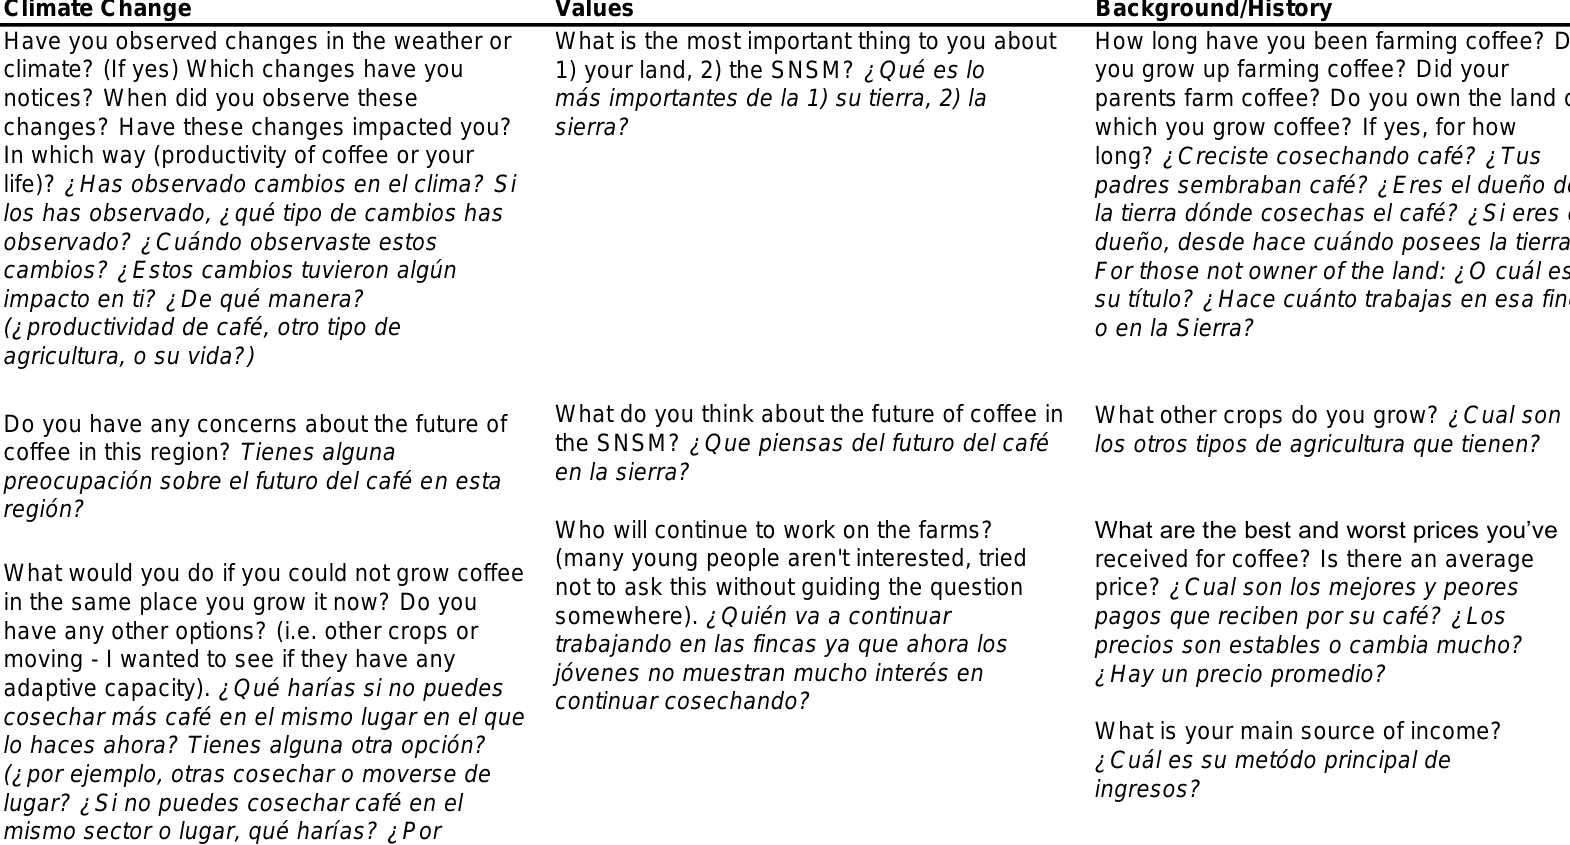
Table A1.2. Focal Group discussion questions, Part 2. Climate Change Values